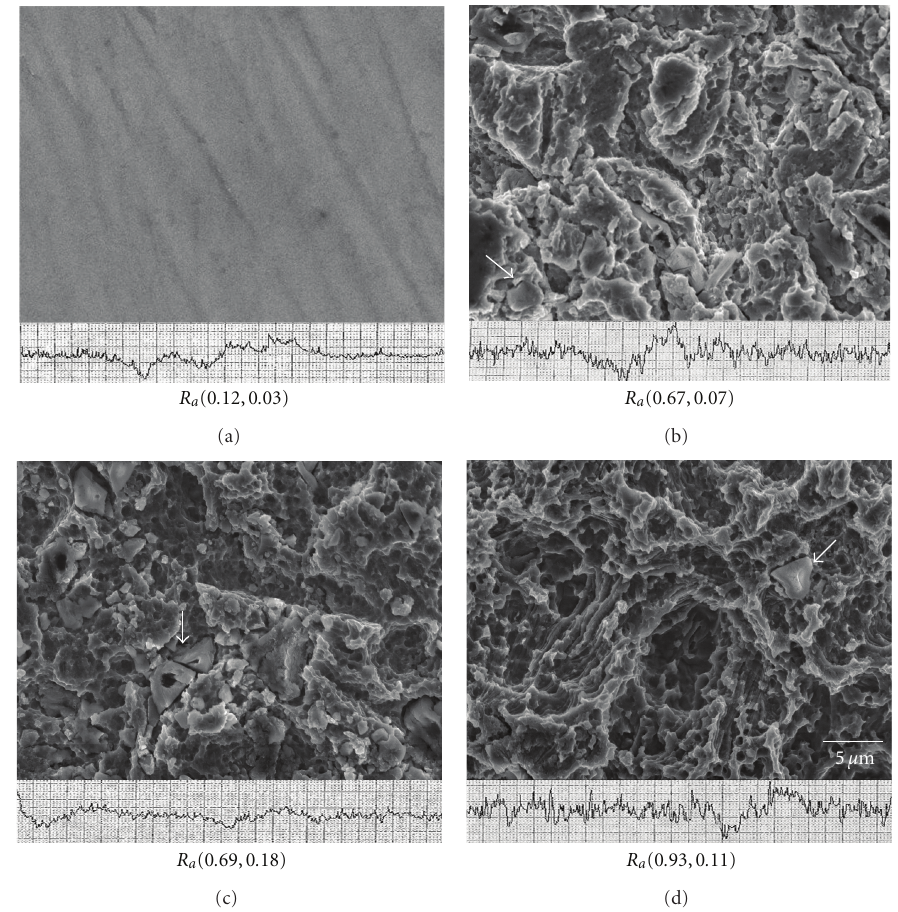
Figure 2: The di ff erent topographies of cp Ti surfaces and their respective levels of roughness after blasting/etching for various times (sec). (a) Control and (b) 10/30, (c) 30/30, (d) 60/30 test groups. Ra: average roughness (mean, SD), units: micrometers. Arrowhead: surface- trapped